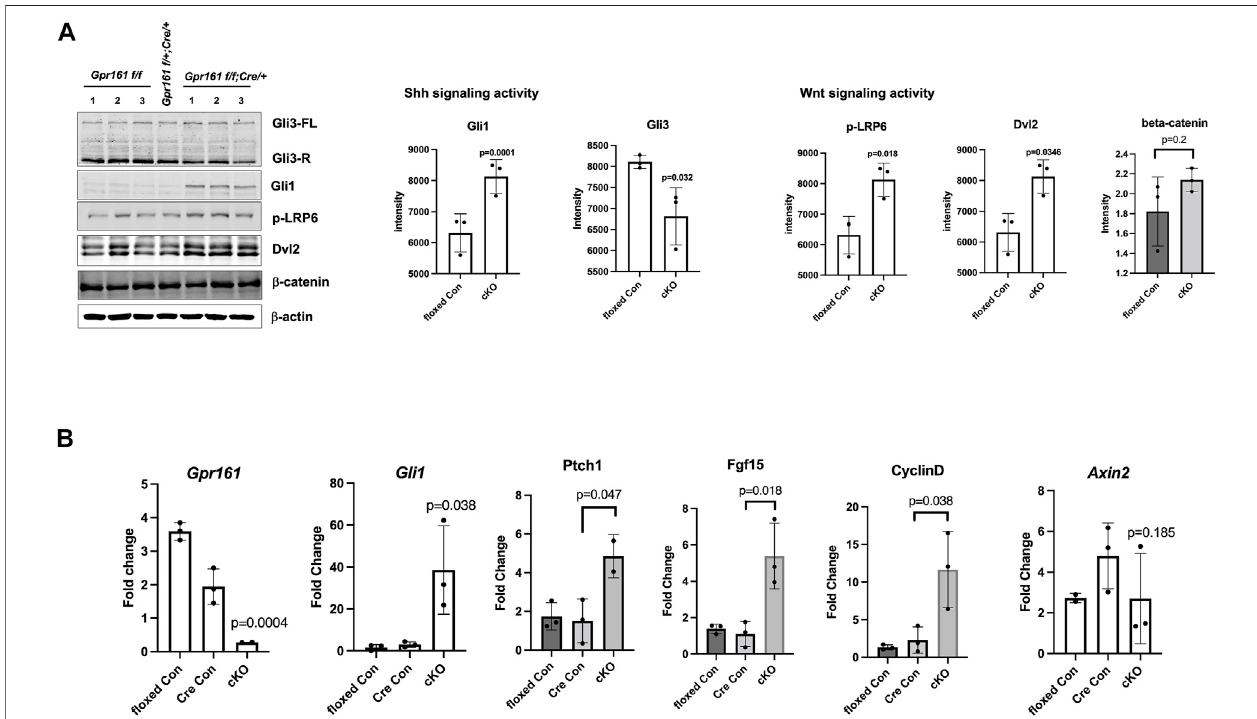
FIGURE 3 | The Shh and Wnt signaling activities in the midbrain of Gpr161 cKO fetuses at E13.5. The dissected midbrain tissues from fl oxed control ( Gpr161 f/f ), Cre control ( Gpr161 f/+ ;Wnt1-Cre/+ ) and cKO ( Gpr161 f/f ;Wnt1-Cre/+ ) fetuses at E13.5 were used for Western Blotting (WB) and qRT-PCR (A) Shh and Wnt signaling activities measured by WB (left). The intensity of each blot was normalized by β -actin. The quantitative analysis (n (cid:1) 3) (right). Gli3 quantitation was done with repressor forms (B) qRT-PCR with Gpr161 , Gli1 , Ptch1 , Fgf15 , CyclinD , Axin2 (n (cid:1) 3), which mRNA levels were normalized with Gapdh